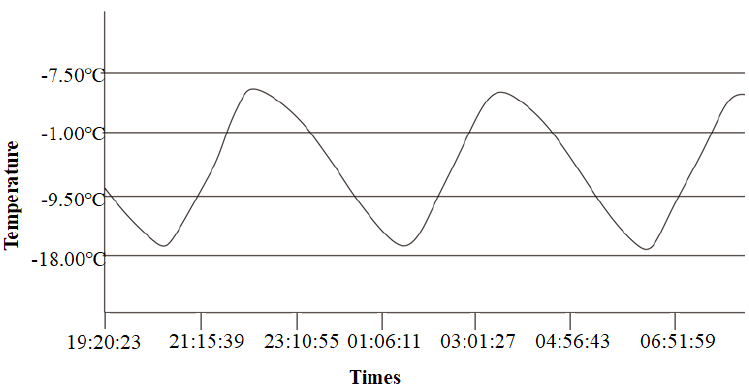
Figure 4. Temperature vs. time curve of freeze–thaw cycles. After the push-out specimens had undergone the rated number of freeze–thaw cycles, the push-out specimens were tested with a microcomputer-controlled electronic universal testing machine, as shown in Figure 5. The load end slip and free end slip were measured by the linear variable displacement transducers (LVDT), as shown in Figure 6. The load end slip was measured by LVDT 1 and LVDT 2, while the free end slip was measured by LVDT 3 and LVDT 4. The experimental data were automatically collected by the load sensor and displacement sensor linked to the computer. The loading methods of the test were graded, and the loading speed was controlled at 0.05 kN/s. When the force–displacement curve of the testing machine display showed obvious nonlinear change, the loading speed was controlled at 0.02 kN/s.